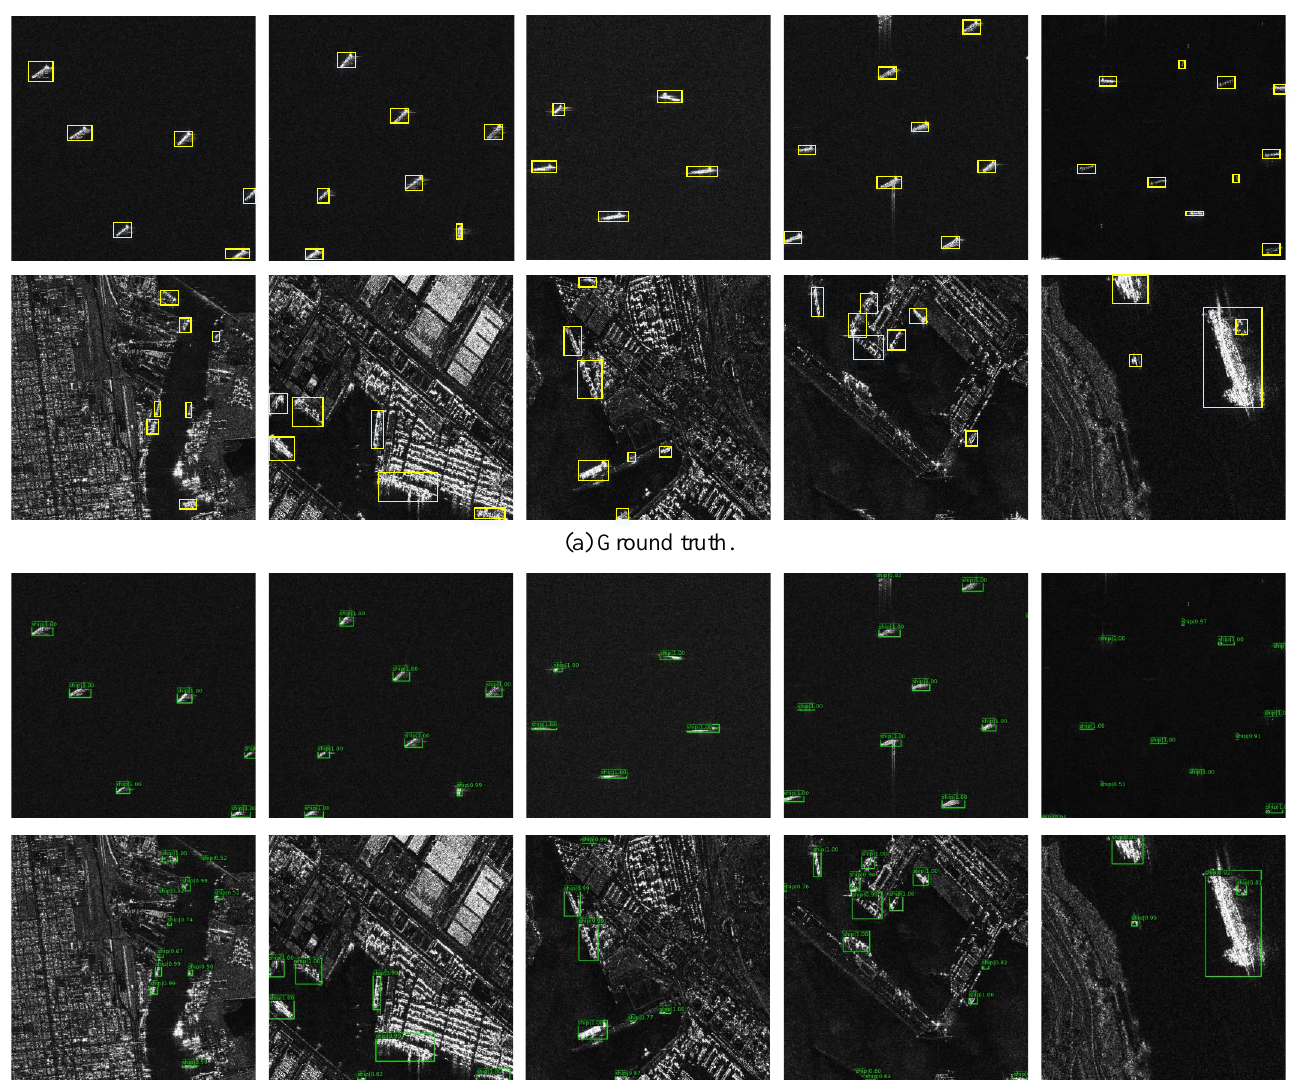
(b) Predicted results of the proposed method. Figure 7. The visualization results are on the HRSID dataset, where the text above the bounding box represents the object category and